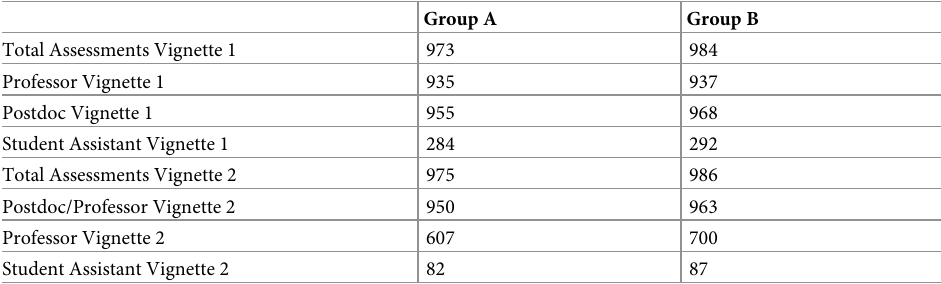
Table 2. Authorship assignments in the vignettes split by treatment